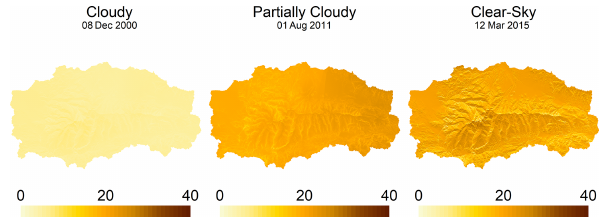
Figure 6. Daily R g (MJm − 2 d − 1 ) in SN for three selected days that represent the three levels of cloudiness considered in this study: cloudy, partially cloudy, and clear